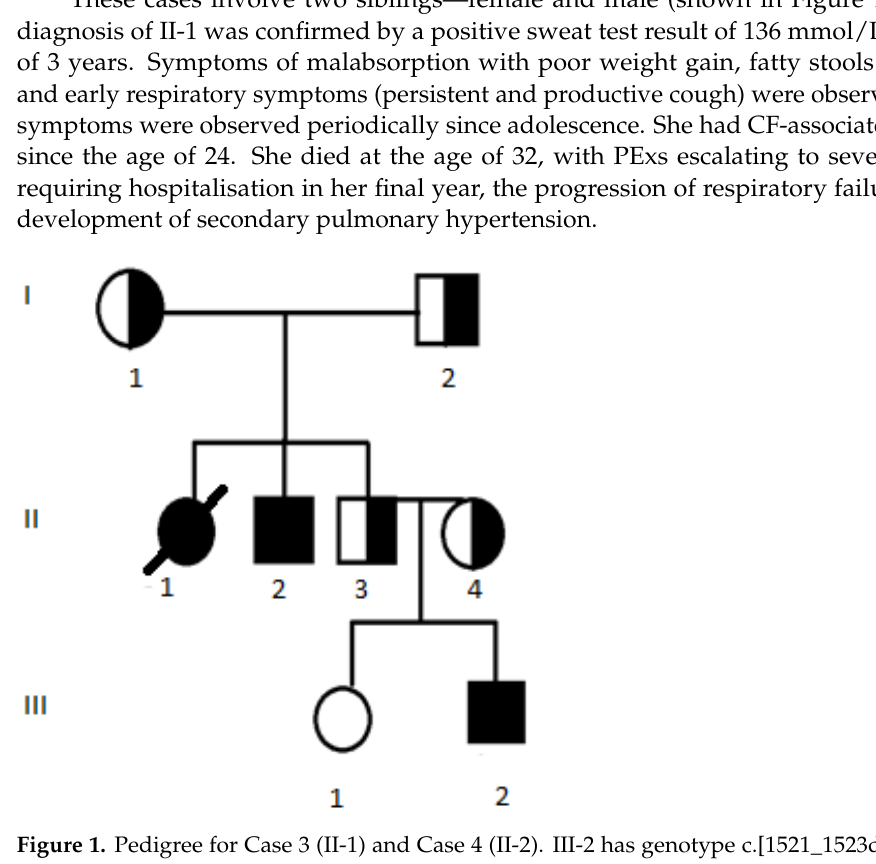
Figure 1. Pedigree